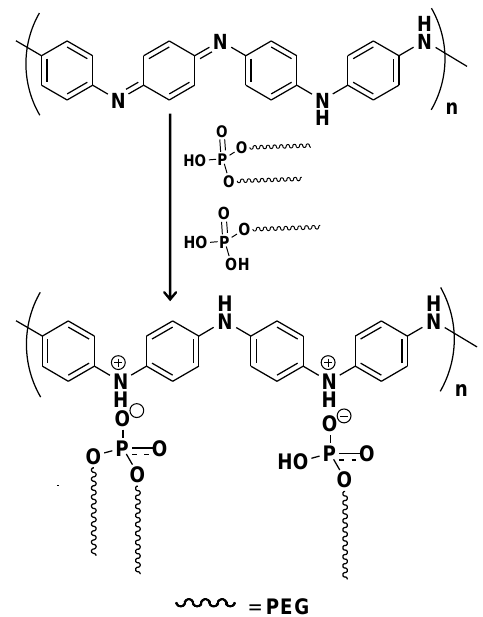
Scheme 5. Structure of the PEG derived phosphoric acid doped PANI.